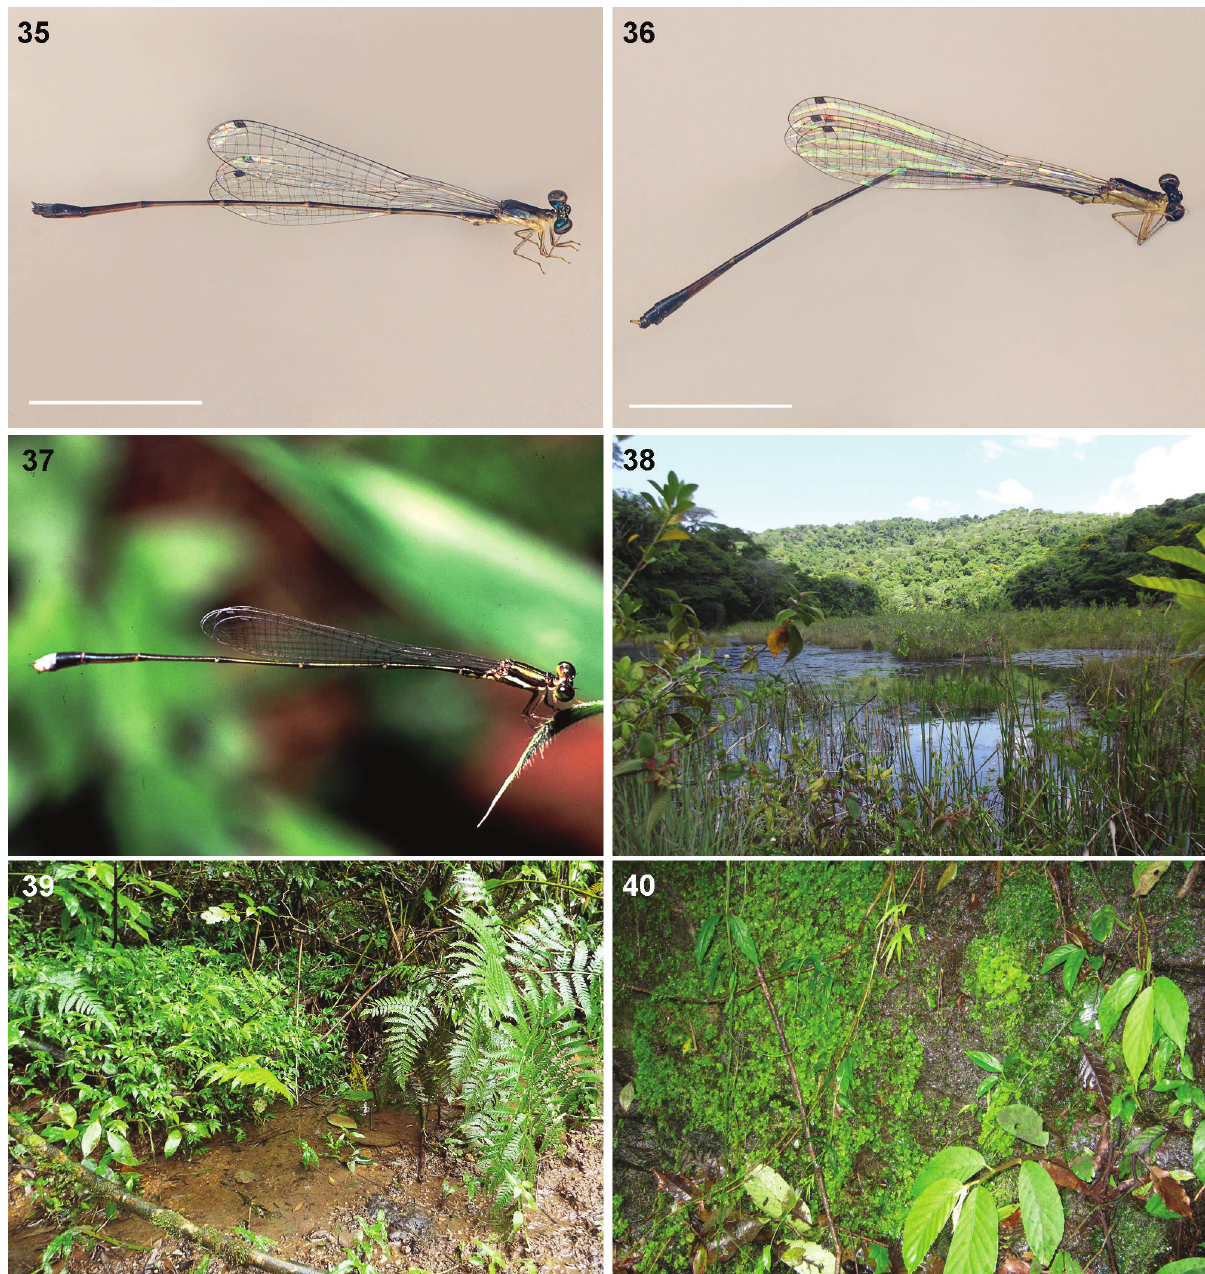
Figures 35–40. Habitus and habitat of species of Forcepsioneura : (35) F. regua sp. nov., holotype (Brazil. RJ: Cachoeiras de Macacu, DZRJ 2071); (36) F. serrabonita sp. nov., holotype (Brazil. BA: Camacan, DZRJ 0050), (37) F. regua sp. nov., live individual at type locality at Reserva Ecológica de Guapiaçu (REGUA); (38) overview of type locality at RPPN Serra Bonita; (39) shallow muddy and slow stream at Itatiaia National Park, typical habitat of small light blue species; (40) seepage covered by hornworts at Três Picos State Park, typical habitat of large orange-black species. Scale bars = 1 mm. Photos: (37) TMFK; (38) RA Carvalho; (39–40)